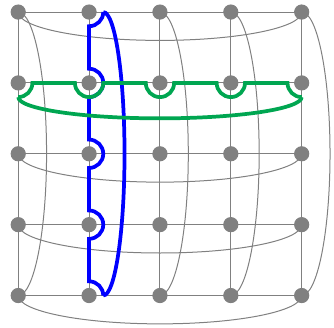
FIG. 3. Representatives of the two classes of nontrivial loops on the nonplanar graph are shown. An h loop is shown in green, while a v loop is shown in